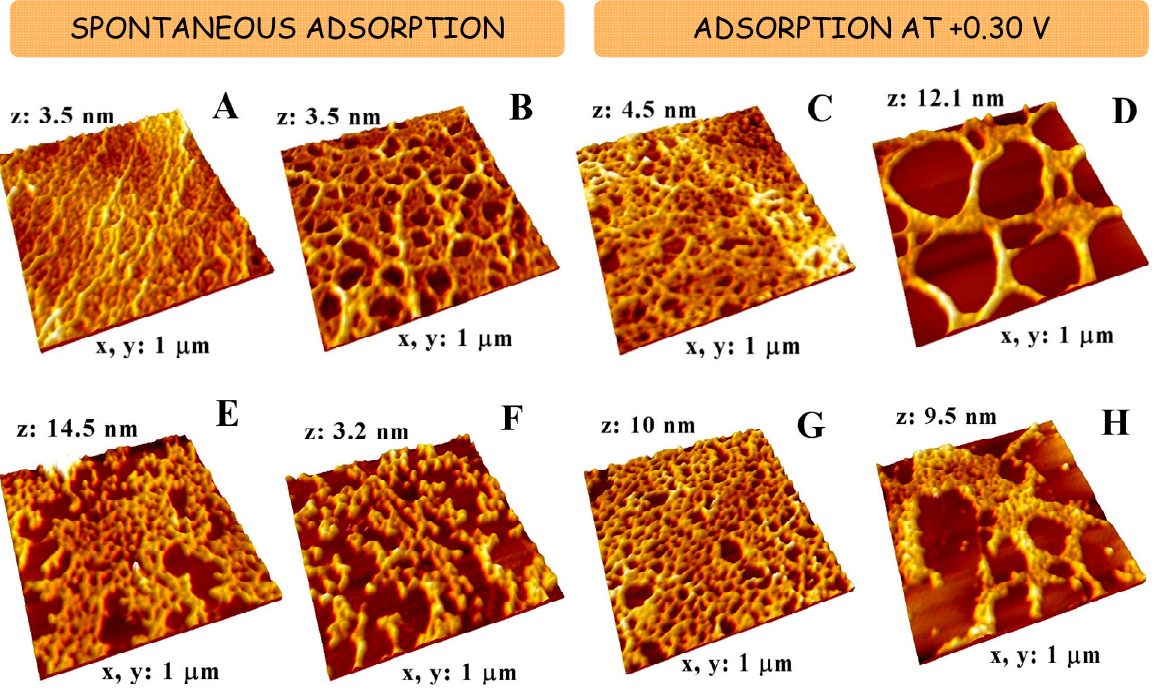
Figure 3. AFM images of the HOPG electrode modified by: I. ( A – D ) 60 µg mL − 1 dsDNA ( A , B ) adsorbed spontaneously and ( C , D ) at applied potential of + 0.30 V (vs. AgQRE), and II. ( E – F ) 5 µg mL − 1 ssDNA adsorbed ( E , F ) spontaneously and ( G , H ) at applied potential of +0.30 V (vs. AgQRE), ( A , C , E , G ) pH 5.3 and ( B , D , F , H ) pH 7.0. Adapted from [58] with permission.